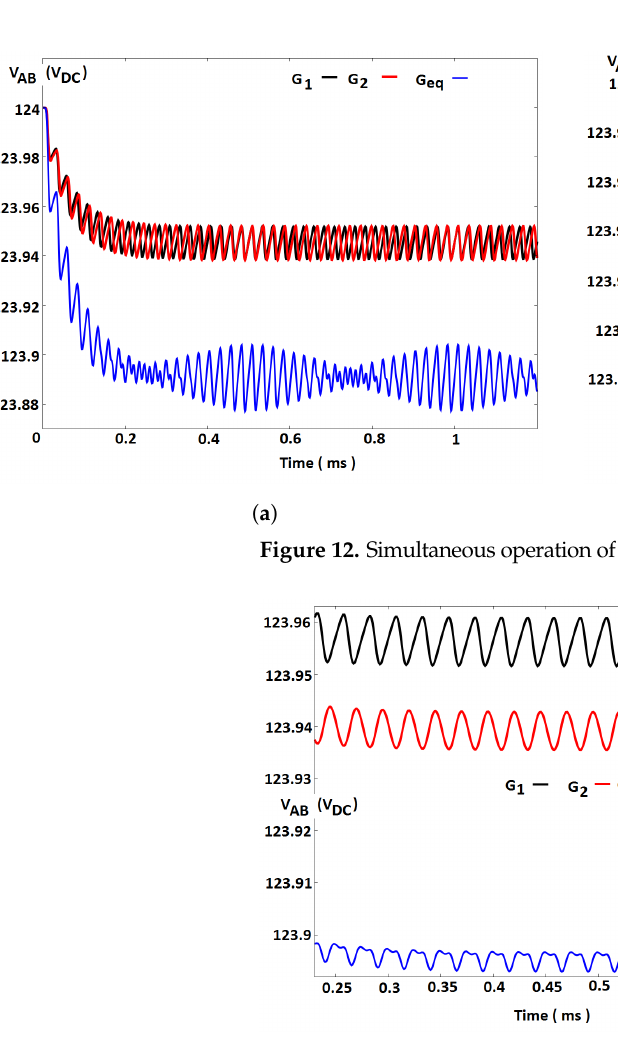
Figure 13. Voltage V AB for a dephasing φ = 4 π /9